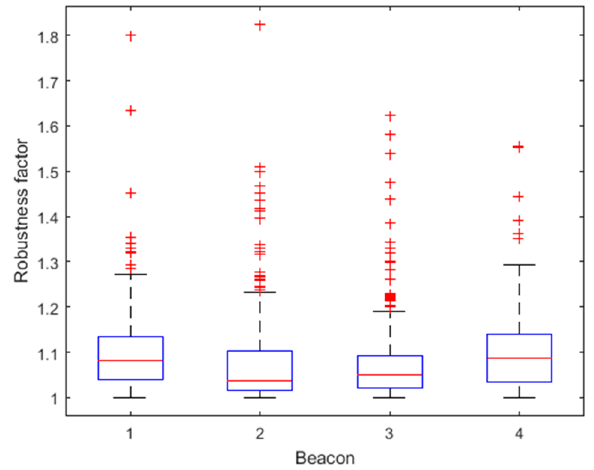
Figure 13. Distributions of residual values for the four Beacons for Route 1.